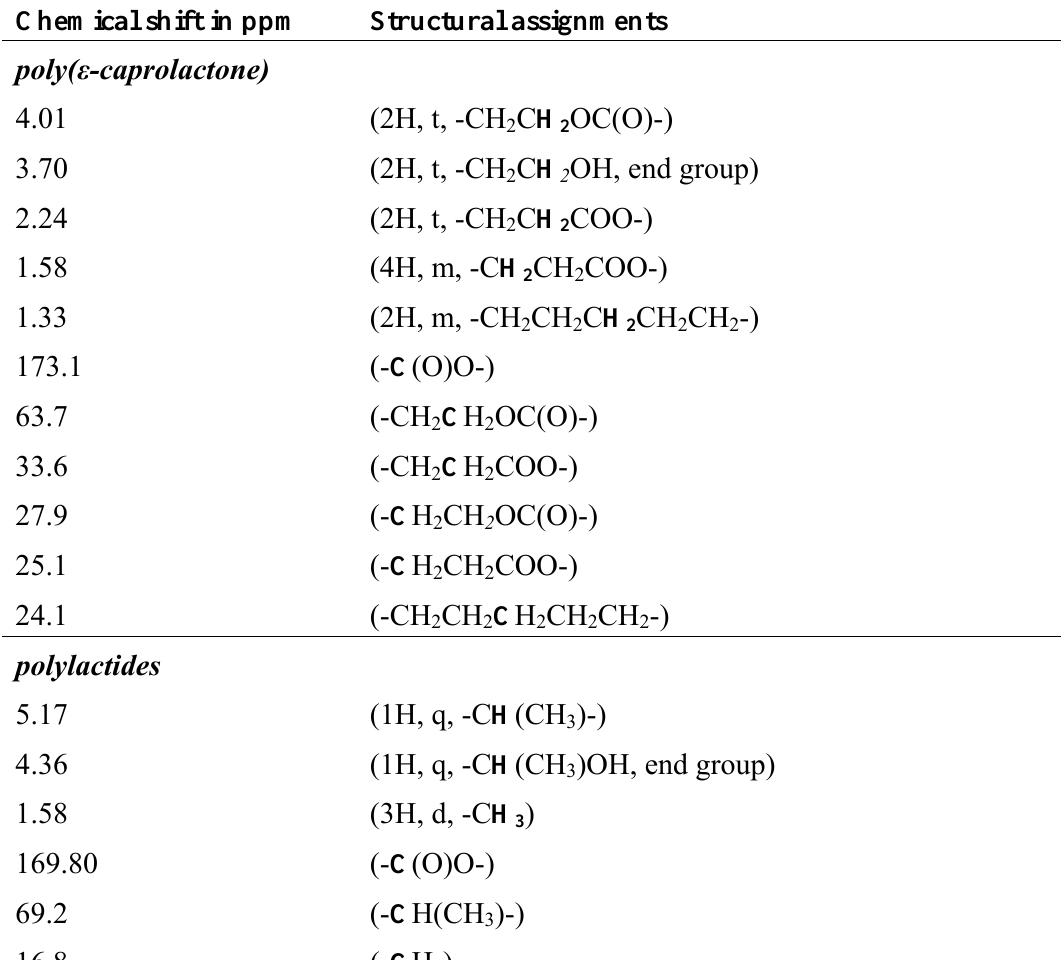
Table 2. 1 H- and 13 C-NMR structural assignments of the synthesized polyesters (spectrum recorded in chloroform at room